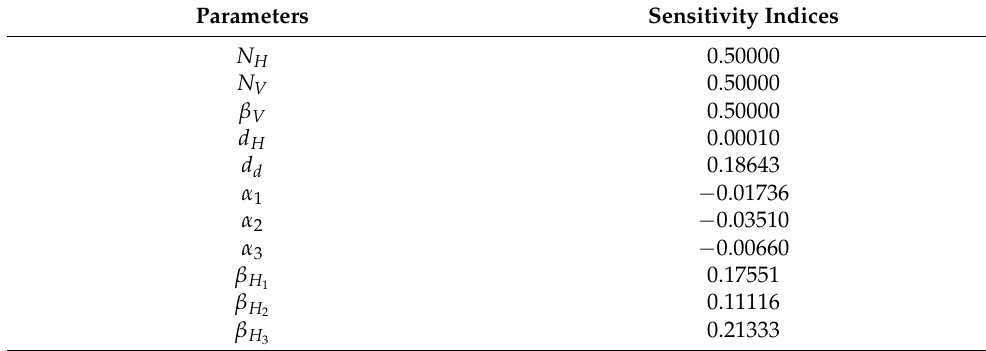
Table 2. Sensitivity